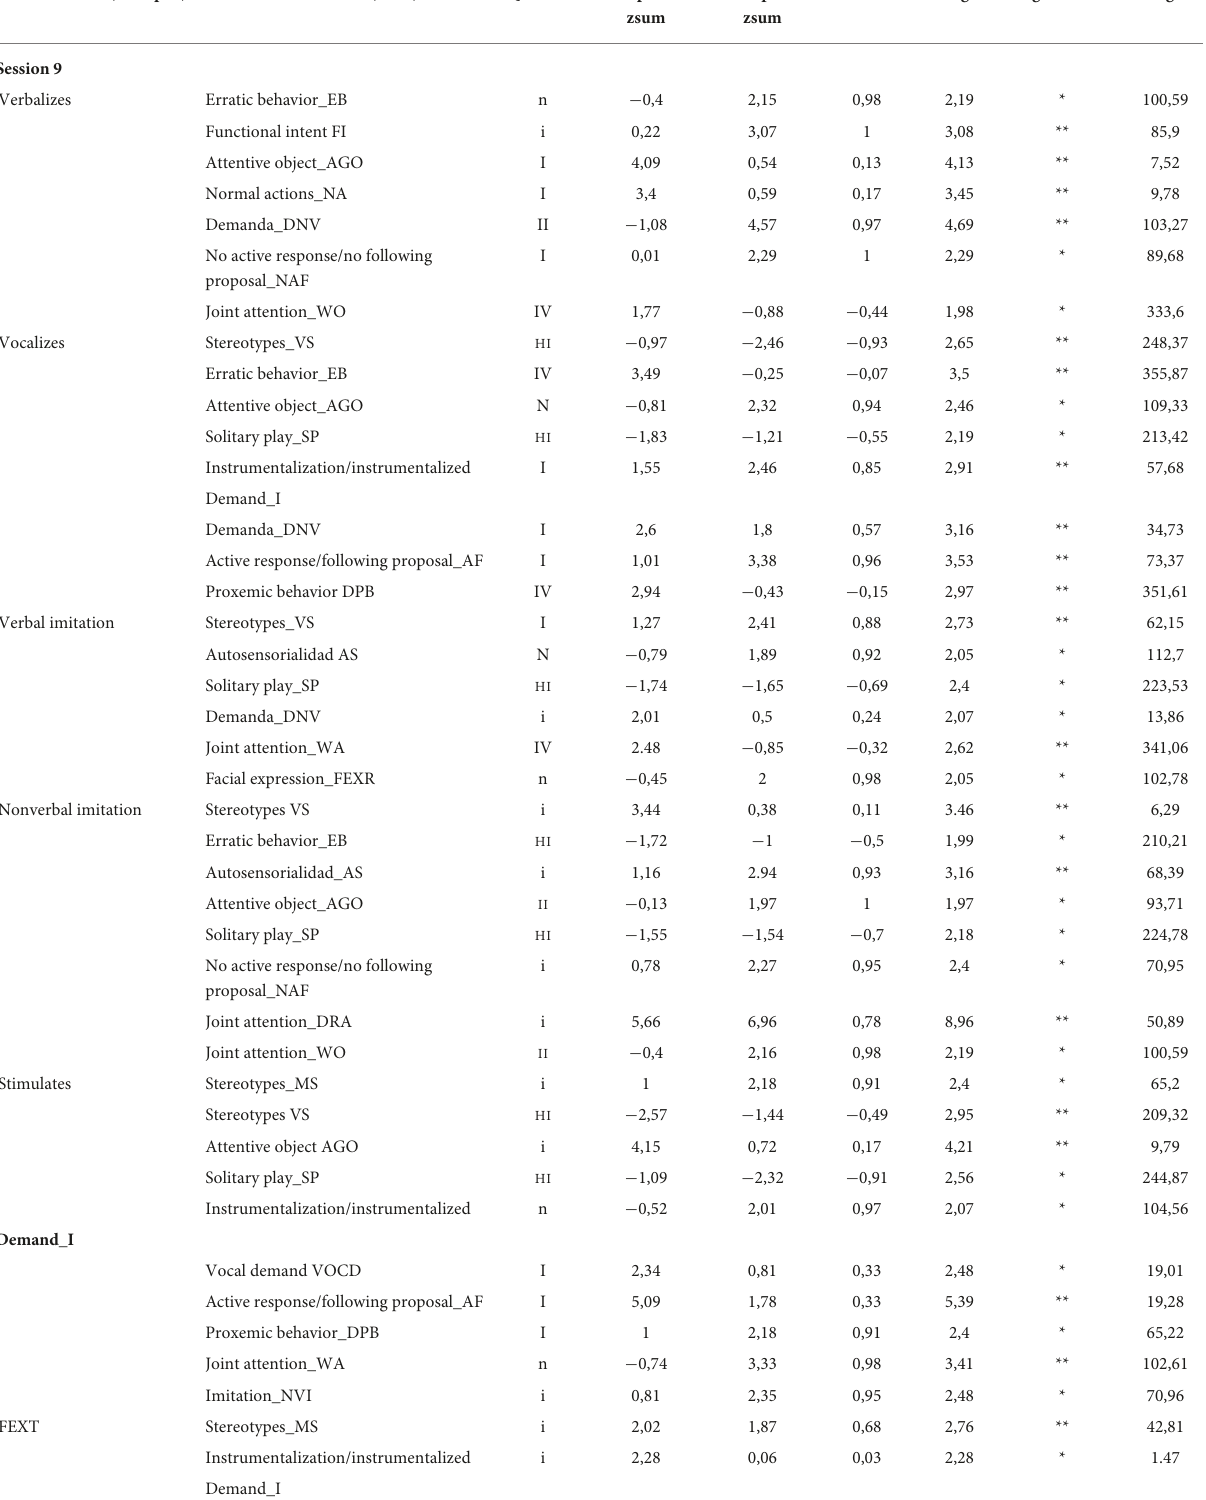
TABLE 3 Table of parameters corresponding to the analysis of polar coordinates, with the focal behavior “Verbalizes,” “Vocalizes,” “Verbal imitation,” “Nonverbal imitation,” “Stimulates,” “FEXT,” and “GA” as the center of the analysis and all the others as conditional of sessions 9, 16, and